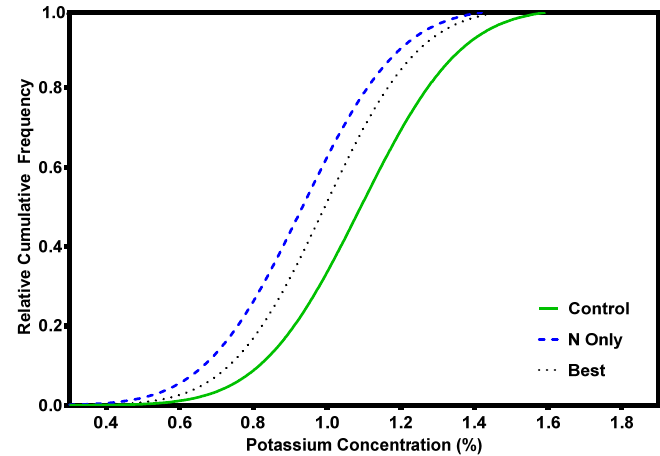
Figure 6. Grand fir foliar K response after fertilization with 224 kg N ha − 1 (N ‐ only) or a blend of 224 kg